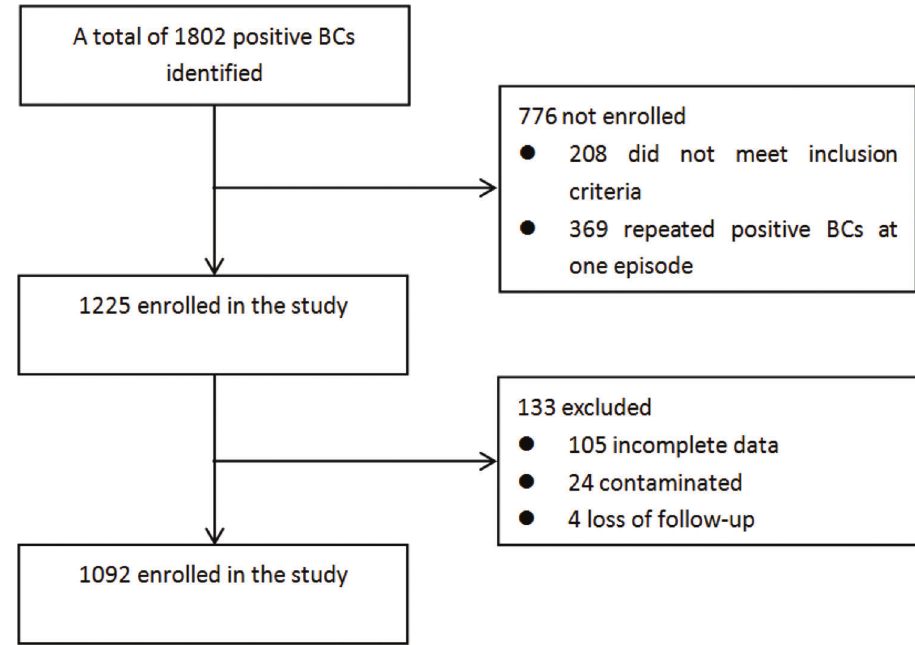
Figure 1 - Study enrollment flowchart. BCs, Blood